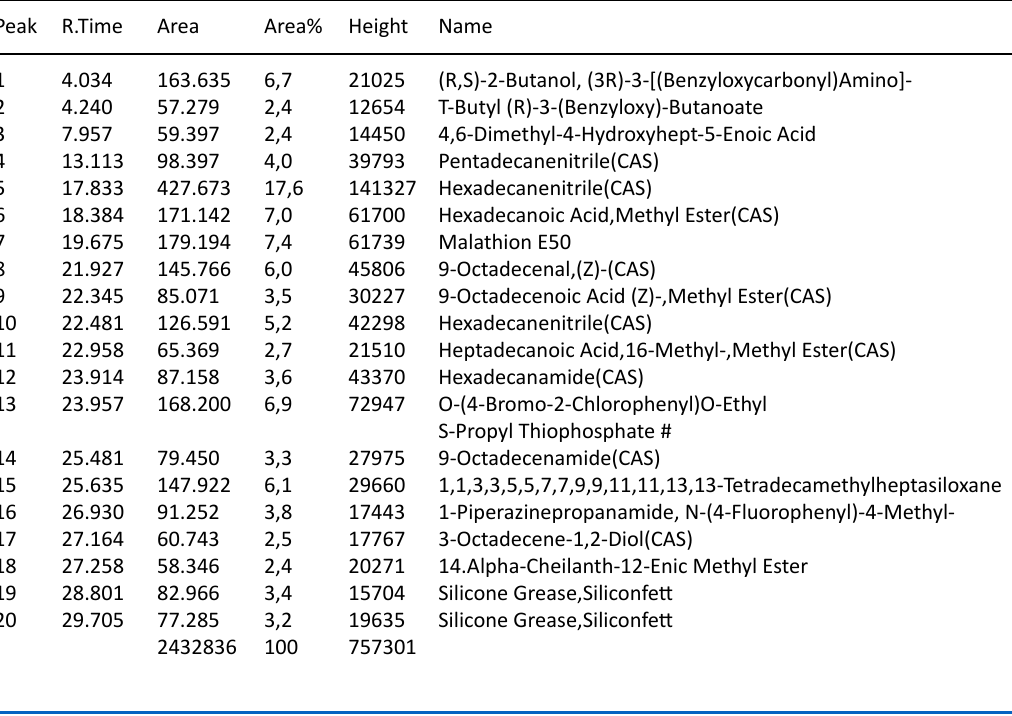
Journal of Pure and Applied Microbiology